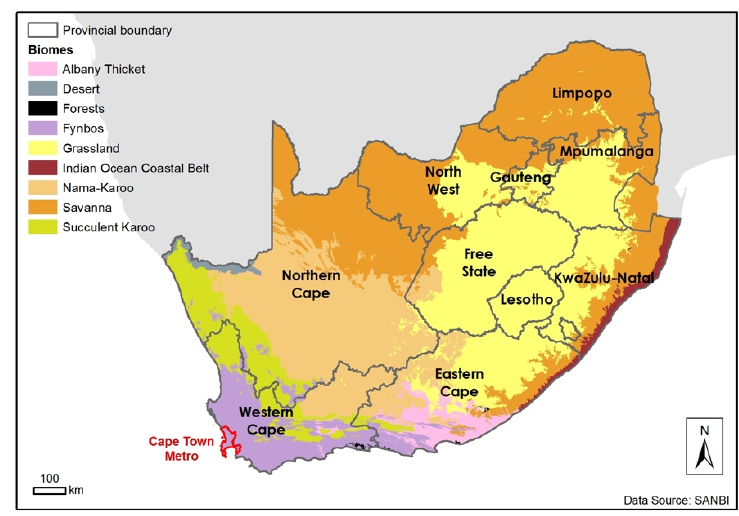
Figure 1. Different biomes in South Africa. The Cape Floristic Region (CFR) or fynbos is indicated by the purple areas in the Western part of the country [17]. (Reproduced with permission from [9]).